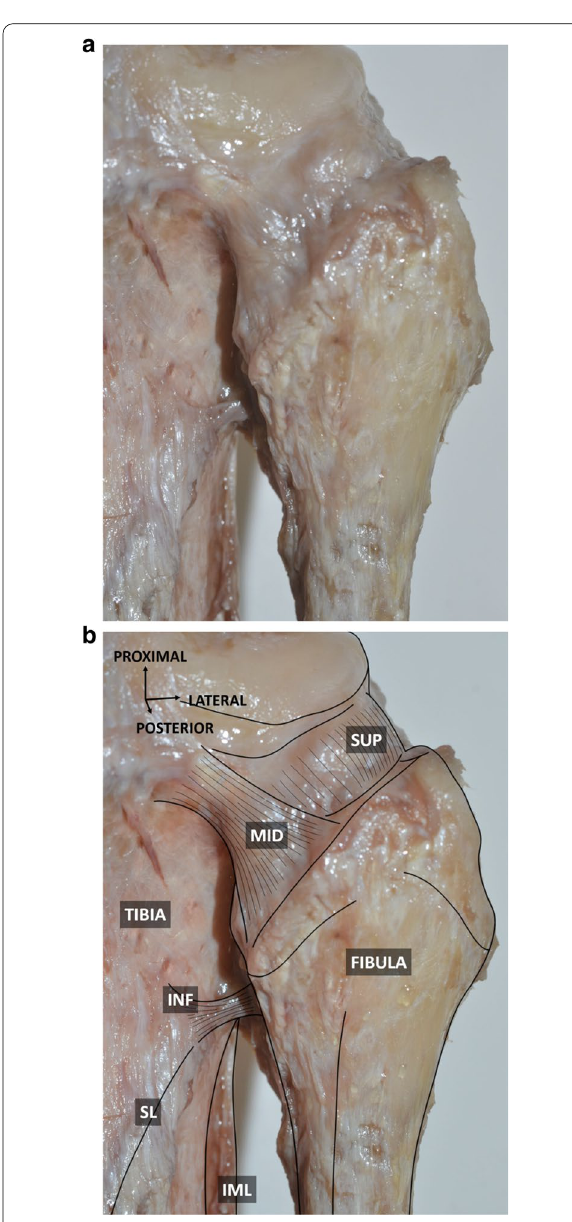
Fig. 3 Posterior view of the proximal tibiofibular joint without ( a ) and with ( b ) annotations. Muscular structures and lateral collateral and popliteofibular ligaments have been removed. The superior bundle can be seen as a thickening of the PTF joint capsule. The inferior bundle can be seen as a reinforcement emanating from the soleus muscle. SUP: superior bundle of the posterior PTF ligament; MID: middle bundle of the posterior PTF ligament; INF: inferior bundle of the posterior PTF ligament; SL: soleal line; IML: interosseous membrane of